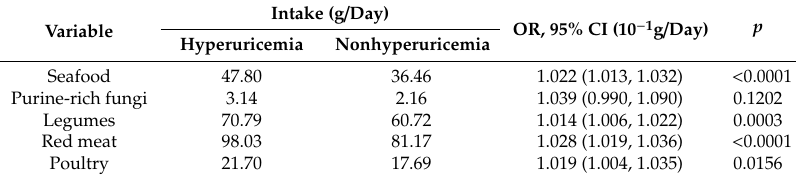
Table 3. logistic regression analysis of various purine-rich food intake and hyperuricemia. Variable